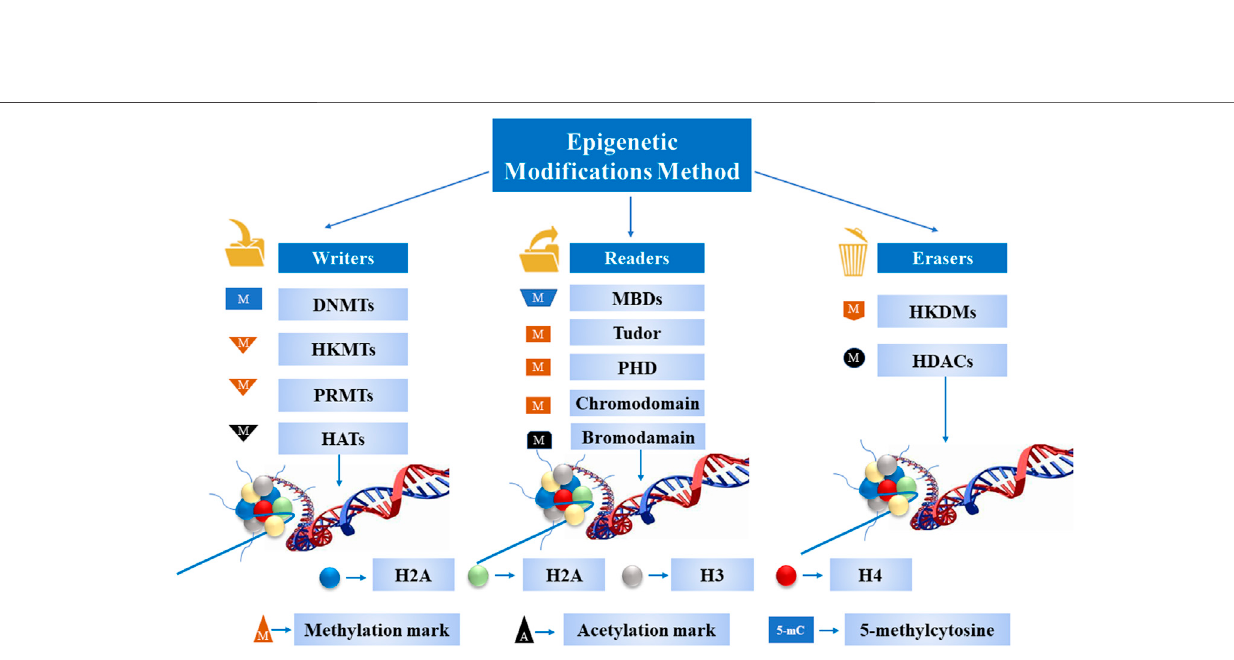
Frontiers in Pharmacology |